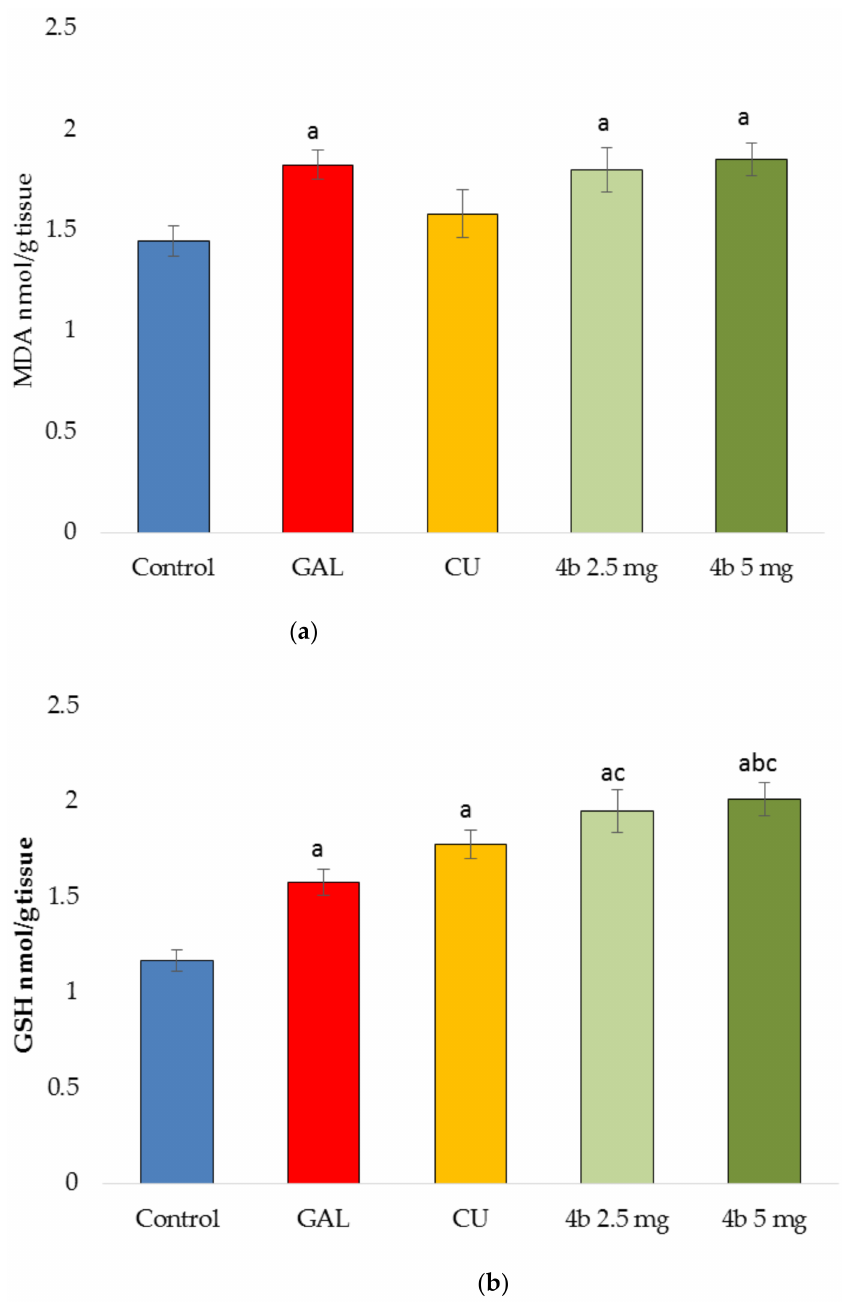
Figure 3. Antioxidant activity measured by malondialdehide (MDA) ( a ) and GSH levels ( b ) in brain homogenates derived from mice treated 14 days by GAL, CU, and 4b in two doses (2.5 mg/kg and 5 mg/kg) or placebo (control group). a p < 0.05 vs. control; b p < 0.05 vs. CU; c p < 0.05 vs.